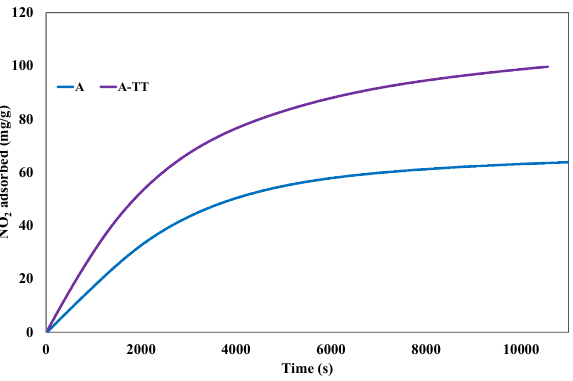
Figure 13. Evolution of the quantity of NO 2 adsorbed at 25 ◦ C on the surface of samples A and A-TT Figure. 13 . Evolution of the quantity of NO 2 adsorbed at 25 °C on the surface of samples A and A-TT until until saturation.